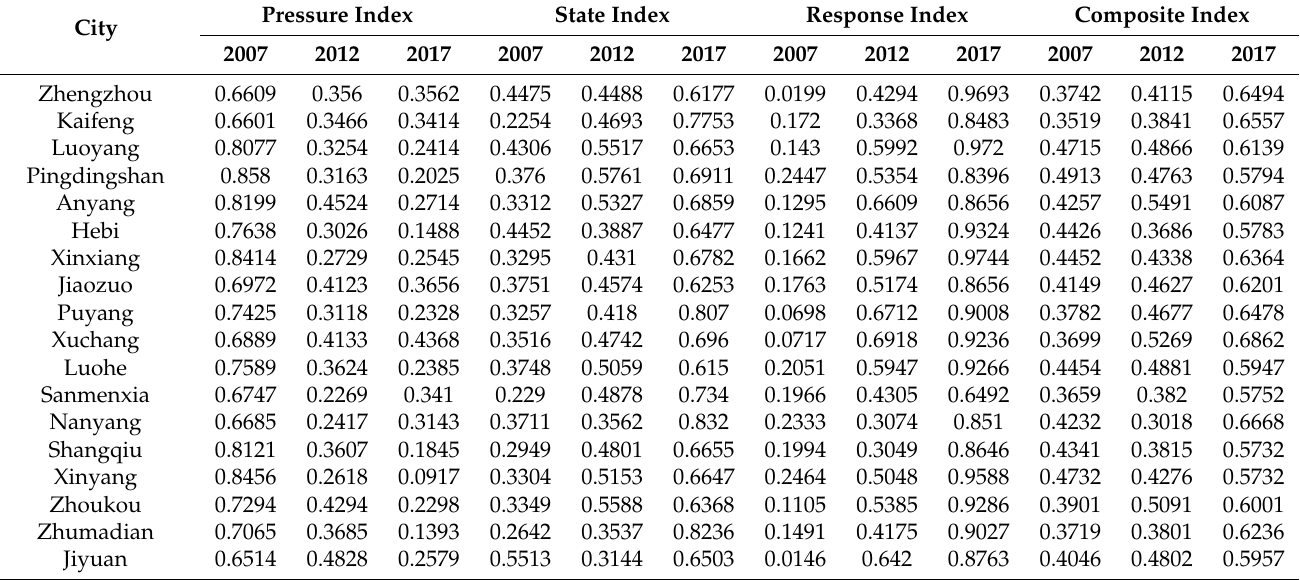
Table A1. Evaluation results of land-use ecological health in Henan Province from 2007 to